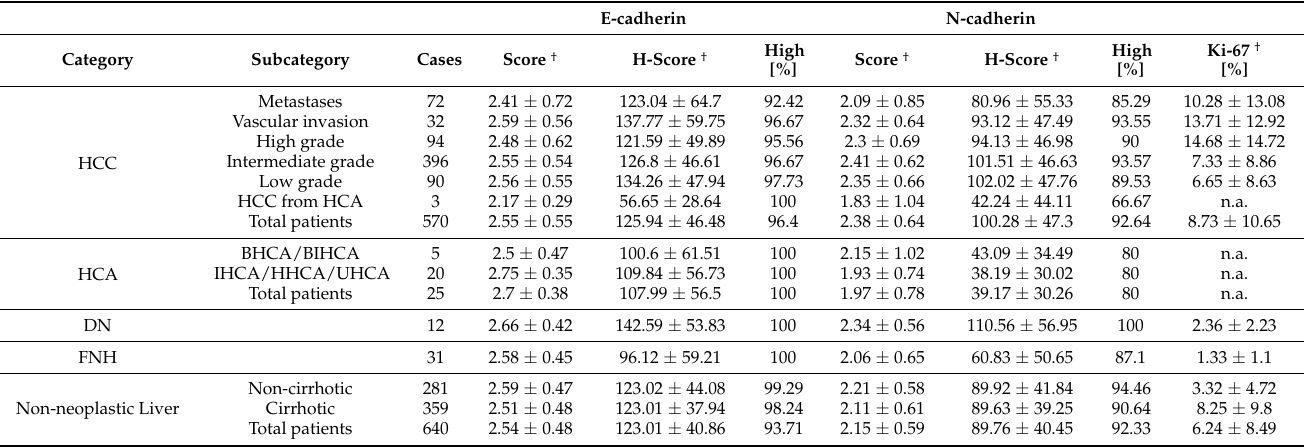
Table 1. Immunohistochemical evaluation of E- and N-cadherin as well as Ki-67 in HCC, HCA, FNH, and non-neoplastic liver